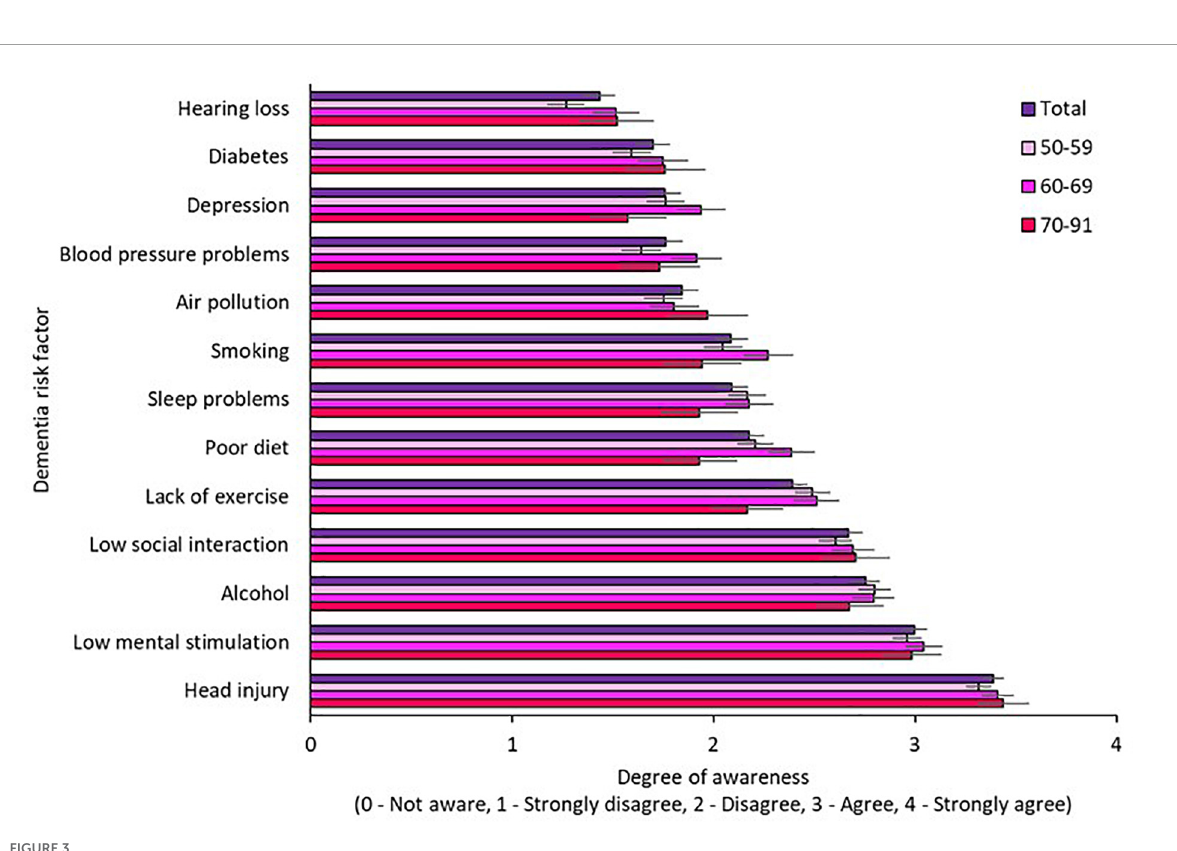
FIGURE3 Awareness of modifiable risk factors by